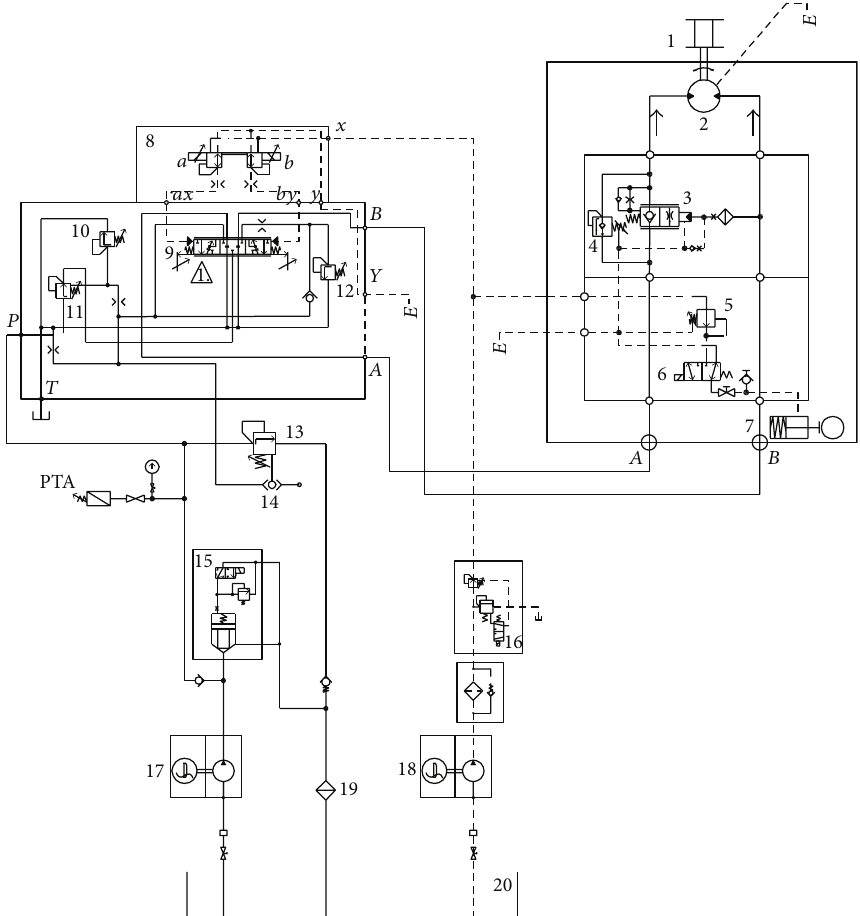
Figure 5: Hydraulic principle diagram of the